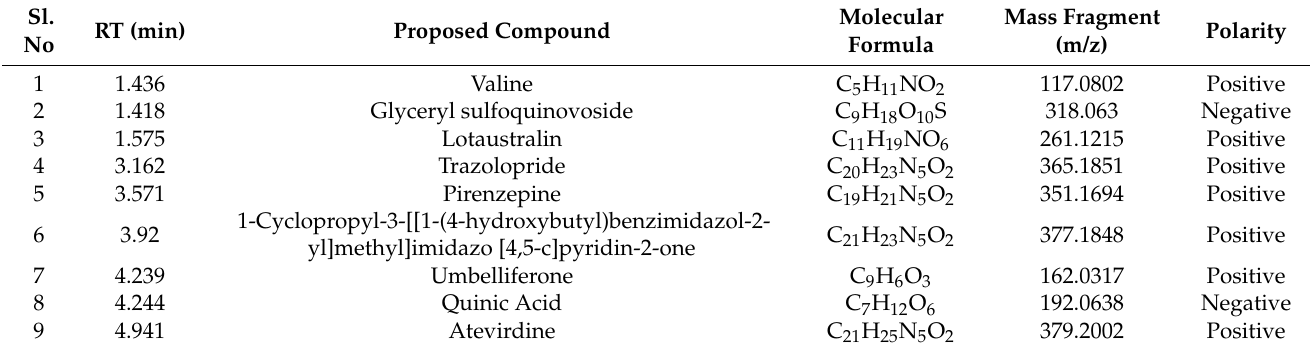
Table 4. LC-MS profile of methanol extract of P. hysterophorus